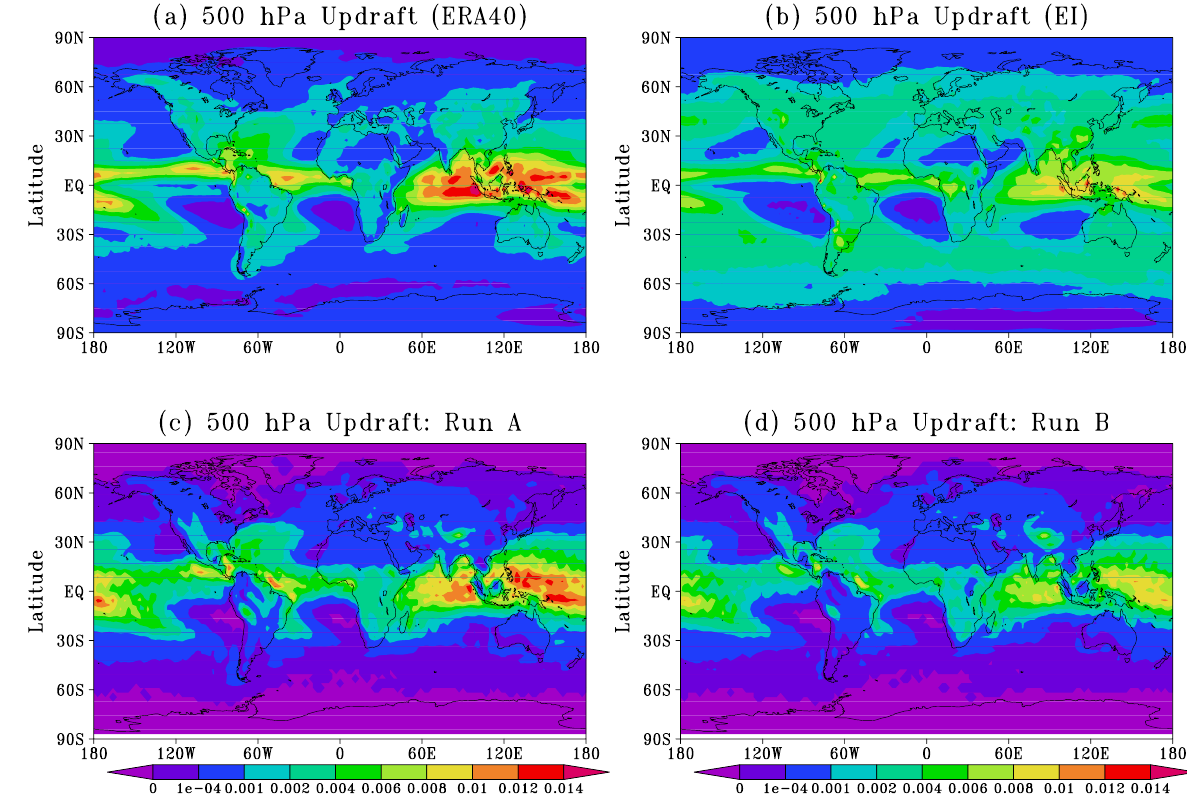
Fig. 1. Climatological convective updraft mass flux (kgm − 2 s − 1 ) at 500hPa averaged from (a) ERA-40 reanalyses (1989–2001), (b)